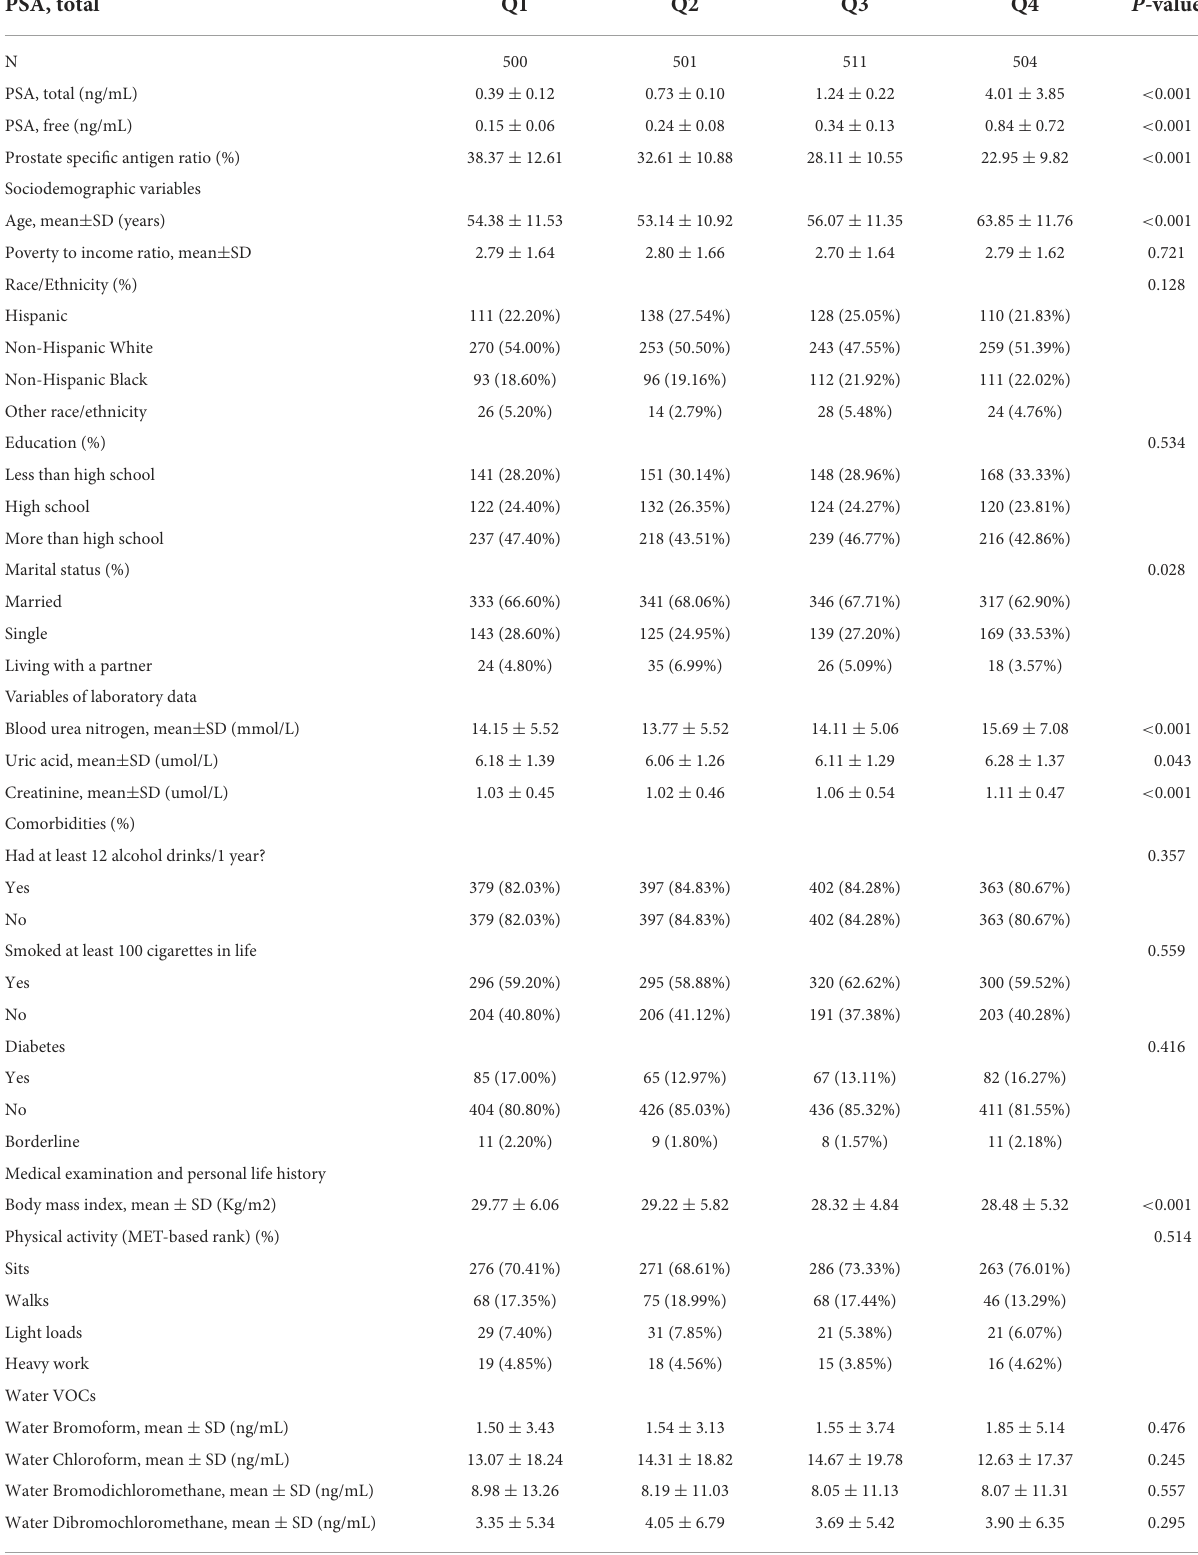
TABLE 1 Baseline characteristics of the study